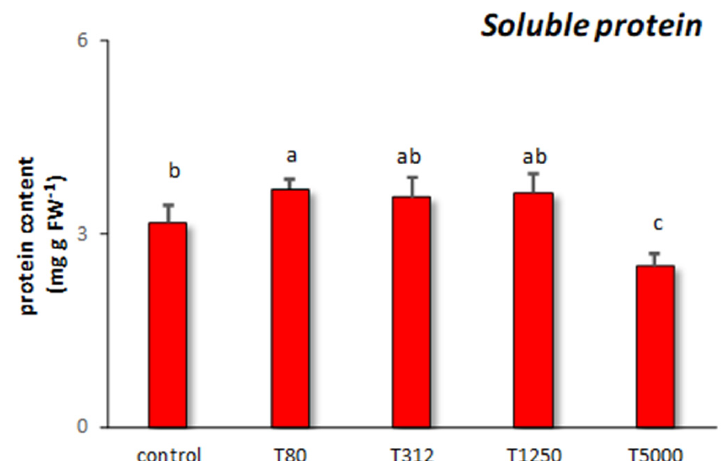
Figure 5. Soluble protein content found in maize samples treated with different concentrations of LNP compared to the control samples (T80, T312, T1250, and T5000 refer to LNP concentration applied to seed for priming). The values were recorded on seedlings at 14 DAS. Letters in the figure, if different, indicate statistically significant differences for p < 0.05 between treatments.